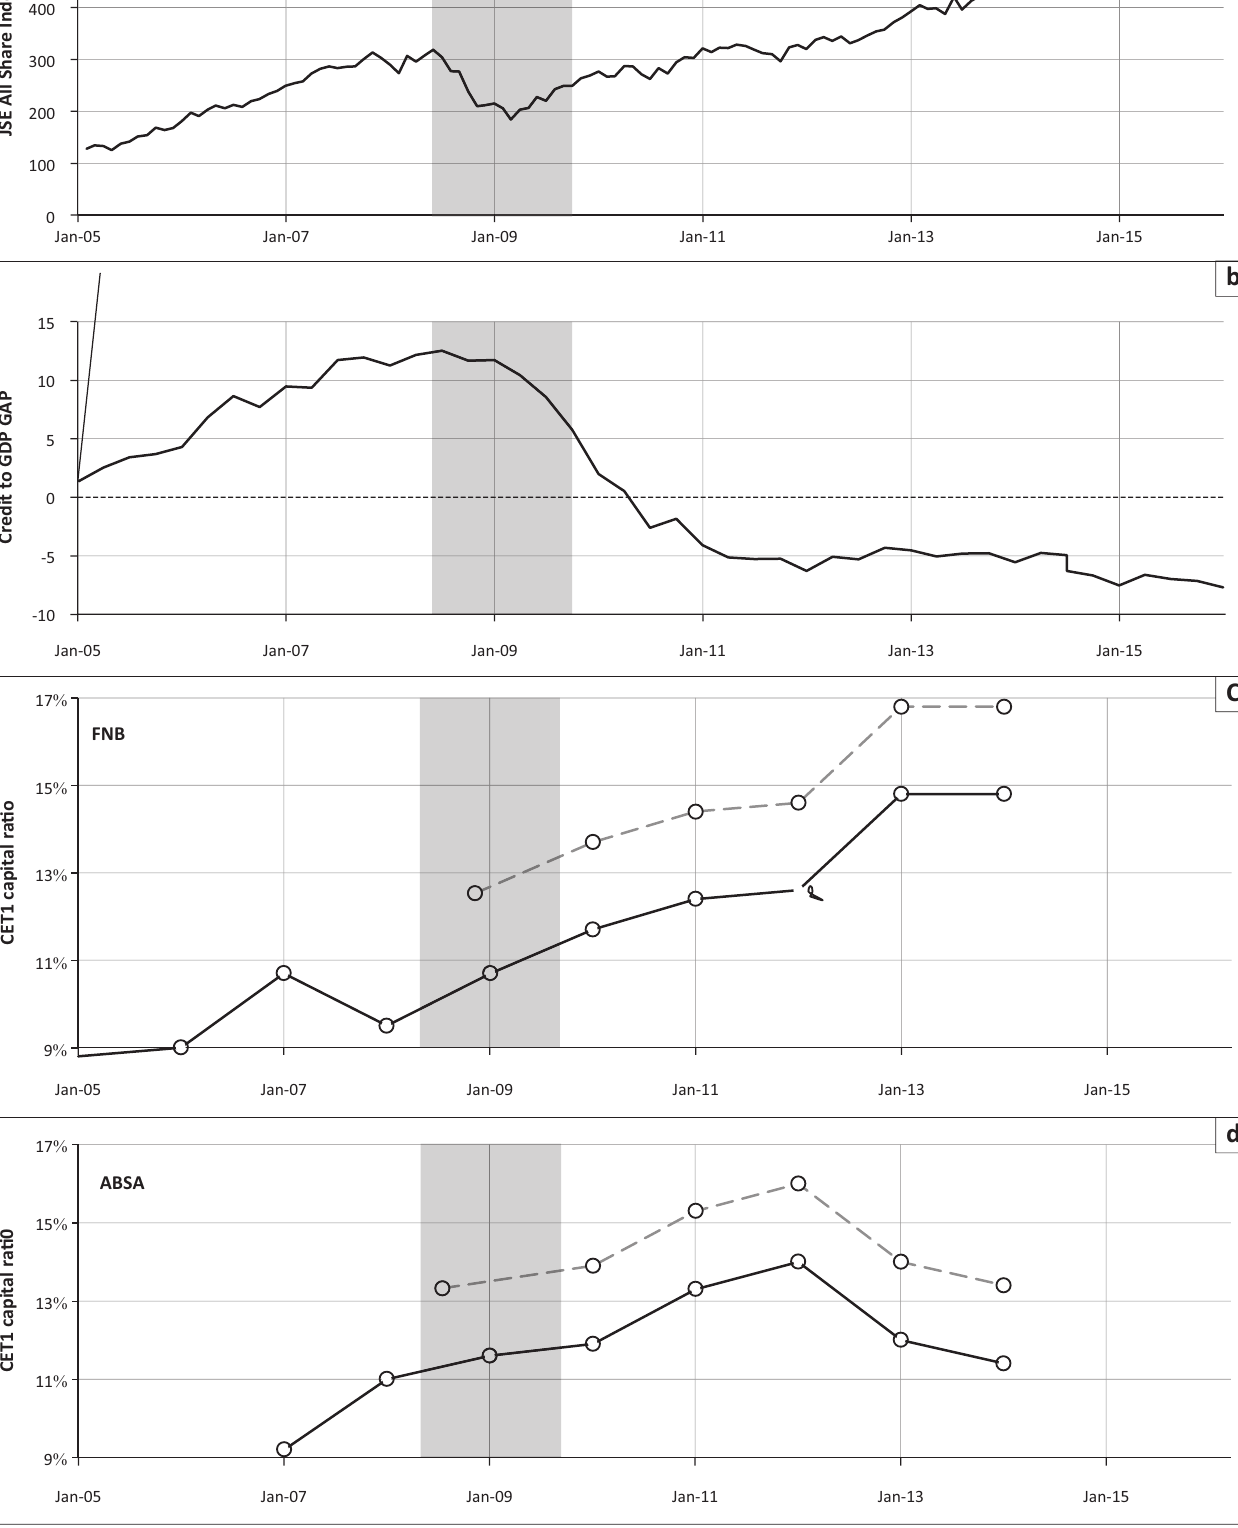
Note: The shaded area represents the fall in the market because of the 2007 credit crisis and illustrates that the simulated contingent convertible triggers could have produced a common equity tier 1 capital injection during this period, for all four banks. FNB, First National Bank; ABSA, Amalgamated Banks of South Africa FIGURE 11: The conversion of proposed contingent convertible instruments of South African banks (a-f) during an economic